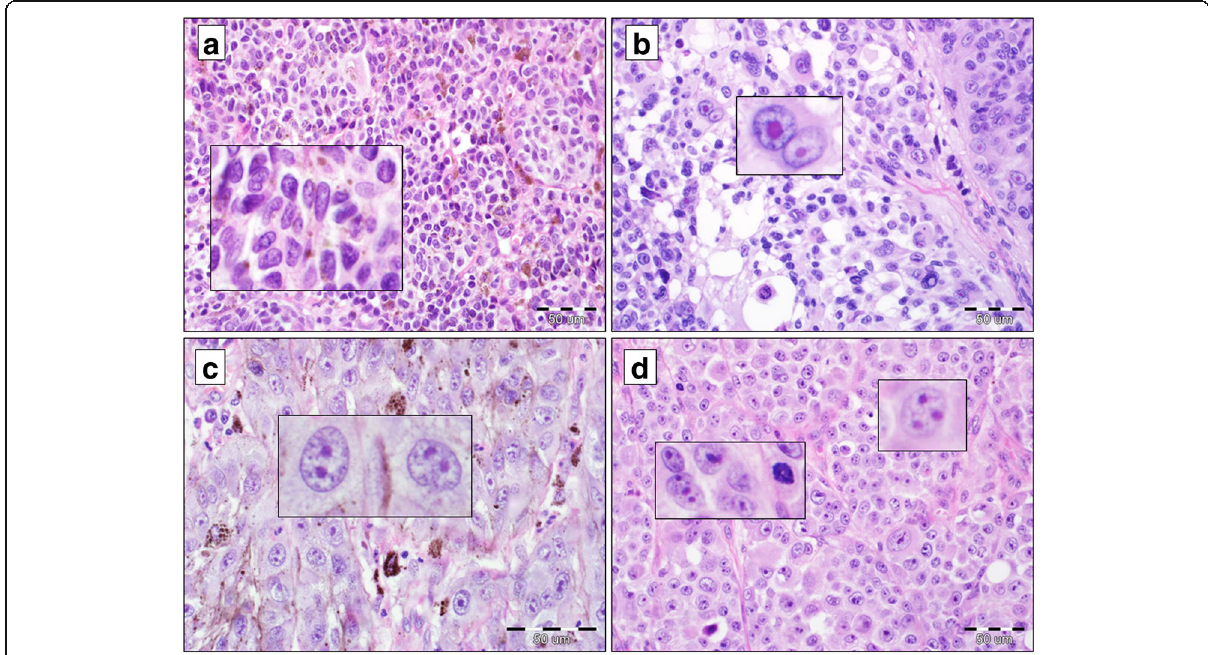
Fig. 1 Cytomorphology of nucleoli in cutaneous melanoma cells. Lack of nucleoli in neoplastic cells (( a ), H&E staining, × 400; insert: H&E staining, × 600). Small number of melanoma cells with visible nucleoli (( b ), H&E staining, × 400; insert: in higher magnification two cells with macro- and micronucleoli, H&E staining, ×600). High representation of cancer cells with distinct nucleoli (( c ), H&E staining, ×600; insert: prominent binucleolization (two nucleoli per one melanoma cell), H&E staining, ×600). High percentage of melanoma cells with prominent nucleoli (( d ), H&E staining, ×400; insert: polynucleolization of melanoma cells (three nucleoli per one melanoma cell, H&E staining,